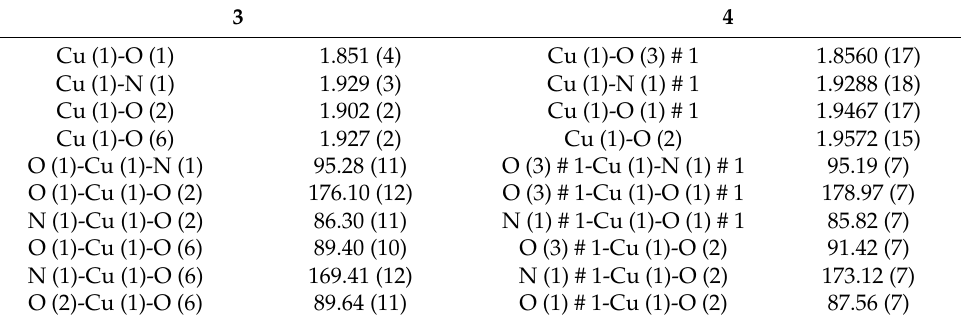
Table 1. Selected bond lengths (Å) and bond angles (°) for 3 and 4 .